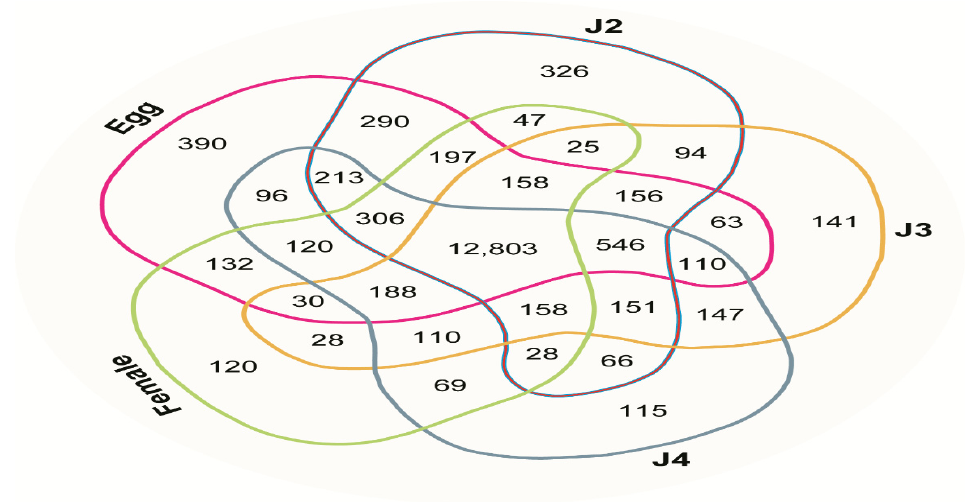
Figure 2. Venn diagram illustrating the distribution of reads across the developmental stages of M. incognita (egg, J2, J3, J4, and female), indicating commonly expressed and stage-specific mRNAs (FPKM ≥